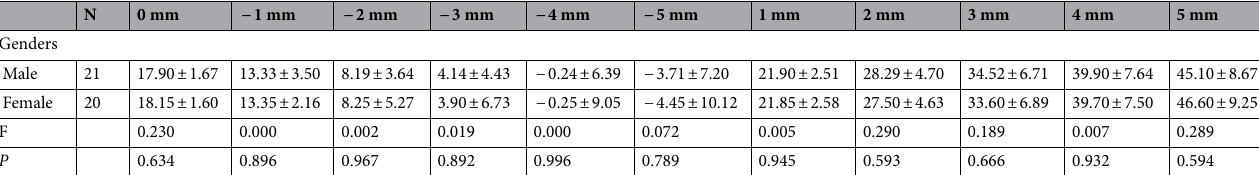
Table 4. The comparison of cup’s anteversion in different genders of normal developmental hips (x ± s).